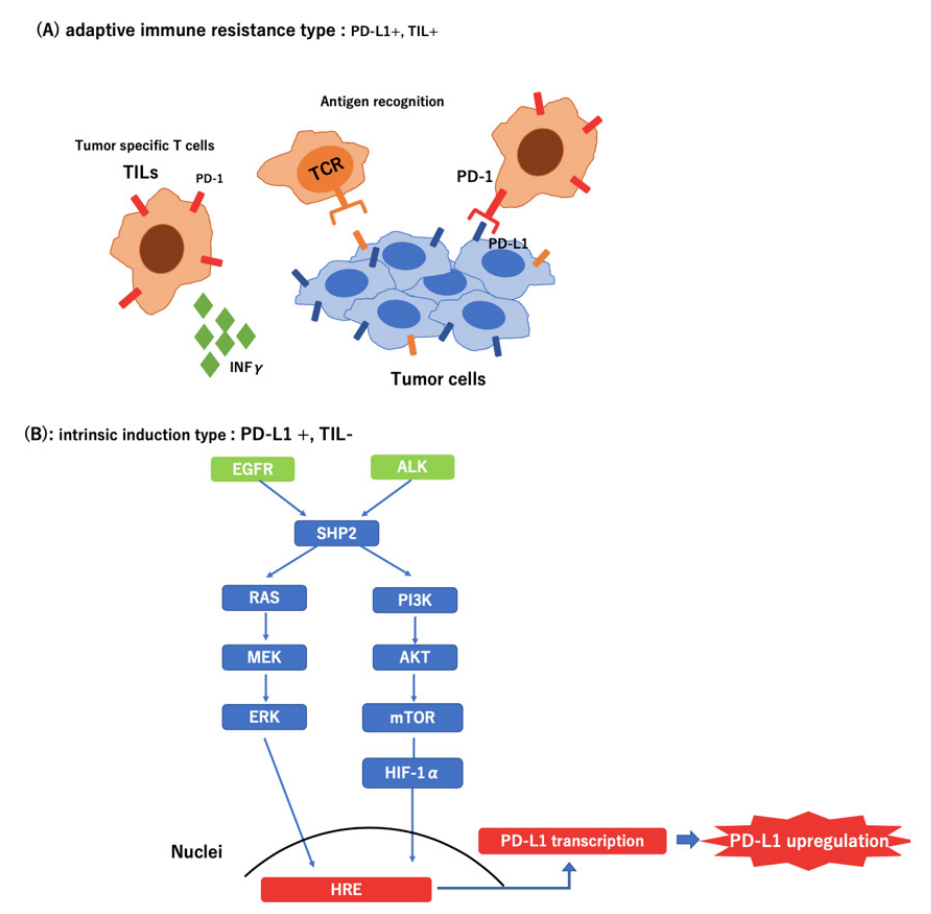
Figure 4. Di ff erent types of tumor microenvironment in PD-L1-positive tumors. ( A ) Adaptive immune resistance type: Tumor Infiltrating Lymphocyte ( + ); ( B ) Intrinsic induction type: Tumor Infiltrating Lymphocyte ( −